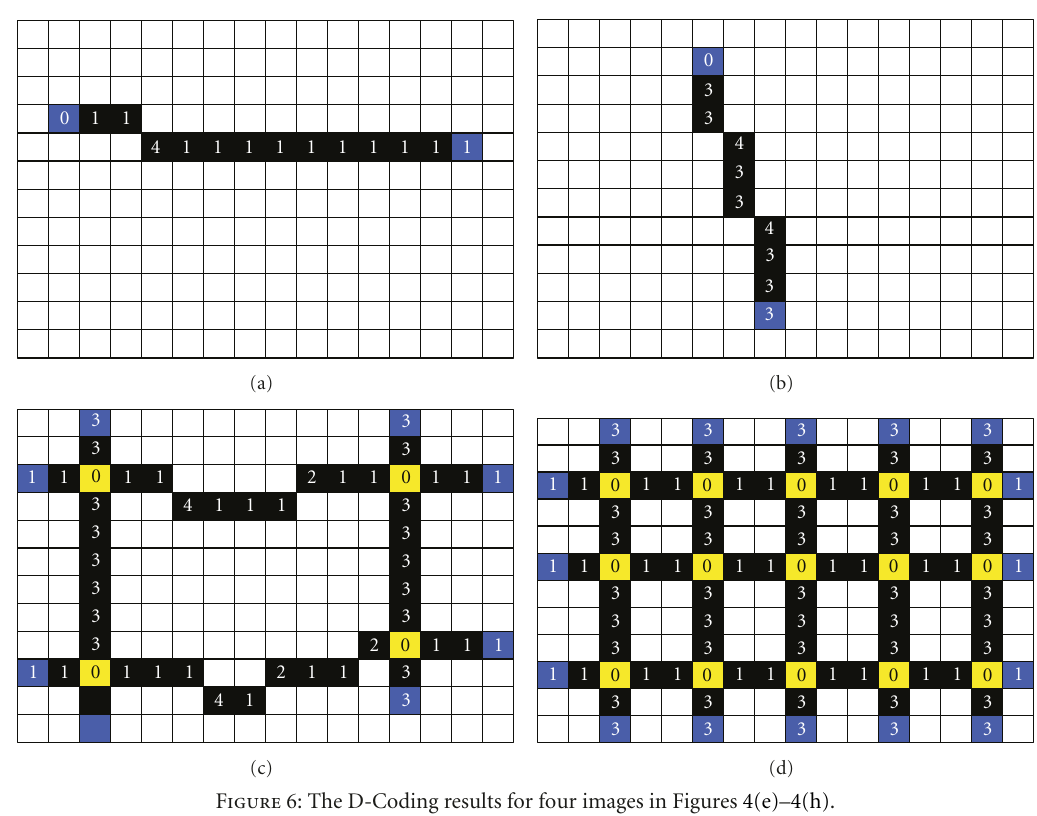
Figure 6: The D-Coding results for four images in Figures 4(e)–4(h).